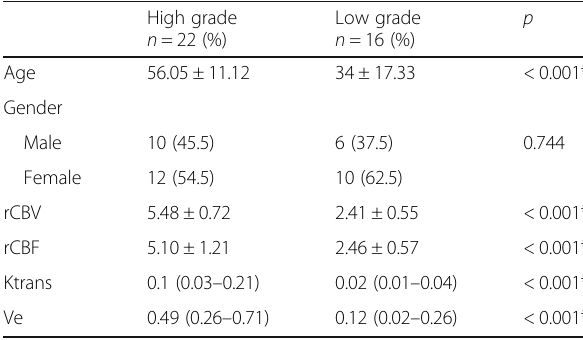
Table 1 Distribution of findings according to high- and low- grade